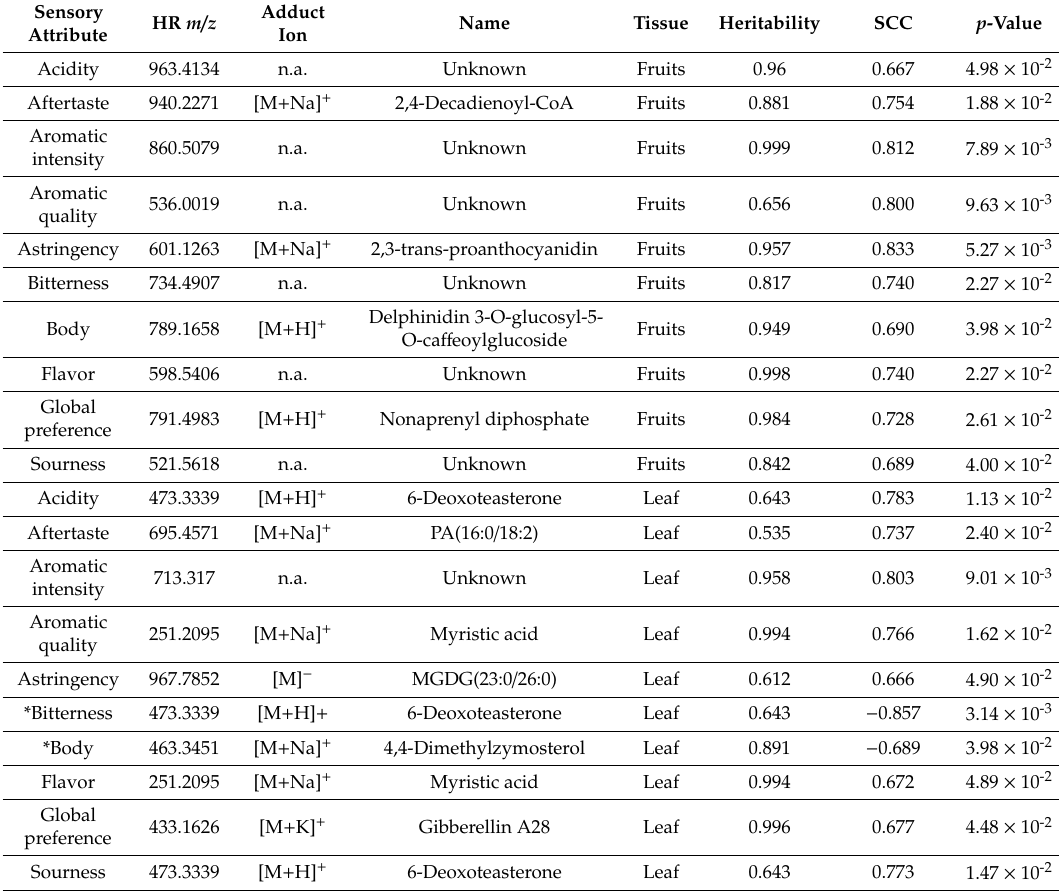
Table 3. Top metabolites of co ff ee fruits and leaf with optimal characteristics (high heritability and strong correlation) linked to sensory